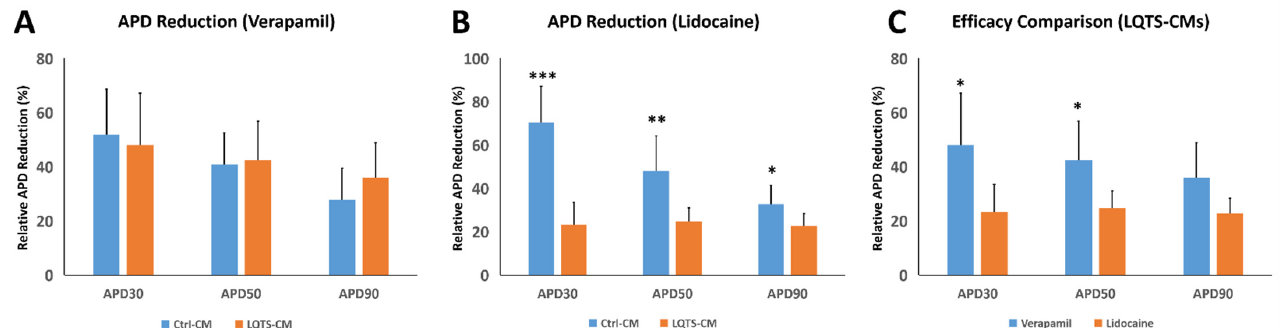
Figure 6. Comparison of QT Interval Shortening Efficacy between Verapamil and Lidocaine. After verapamil treatment, Ctrl-CMs and LQTS-CMs demonstrated no significant difference in relative QT interval shortening ( A ). After lidocaine treatment, however, QT interval reduction in Ctrl-CMs was significantly larger than LQTS-CMs ( B ). In LQTS-CMs, verapamil treatment achieved a significantly larger relative QT interval reduction in terms of APD 30 and APD 90 than lidocaine ( C ). All experiments were of n = 3 or larger. * = p ≤ 0.05; ** = p ≤ 0.01; *** = p ≤ 0.005.